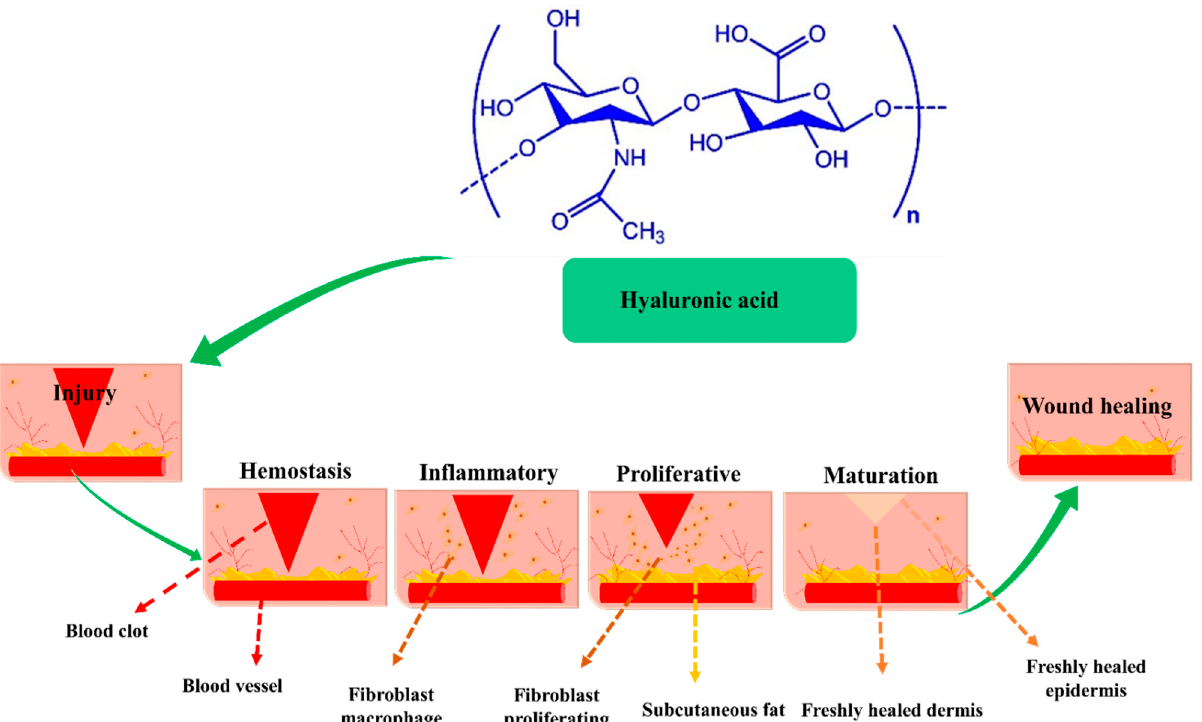
Figure 1. The influence of HA at wound sites during the hemostasis, inflammation, proliferation, and remodeling phases of wound healing, Copyright 2017, ACS publication [36]. Table 1. A Summary of Wound Healing.